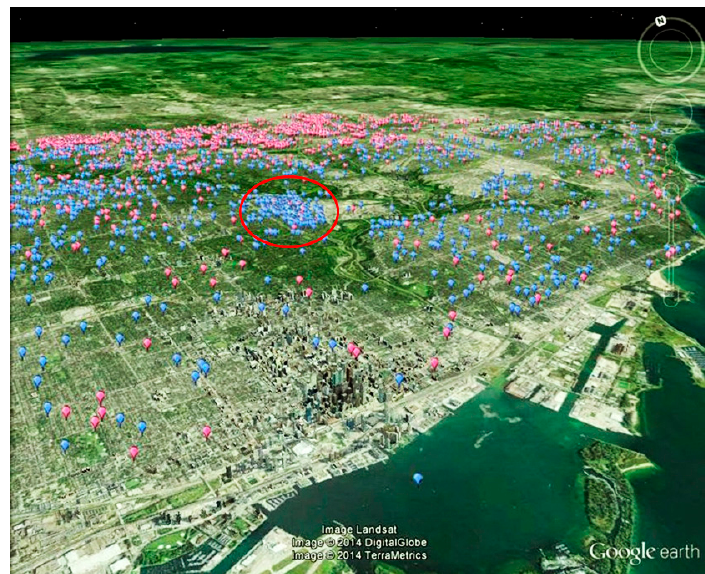
Figure 11. Reported Flooding Locations (Example looking northeast from Toronto Harbour). Blue markers: 12 May 2000 storm; Pink markers: 19 August 2005 storm. Source: http://www.cityfloodmap.com/2014/07/toronto-flood-map.html.